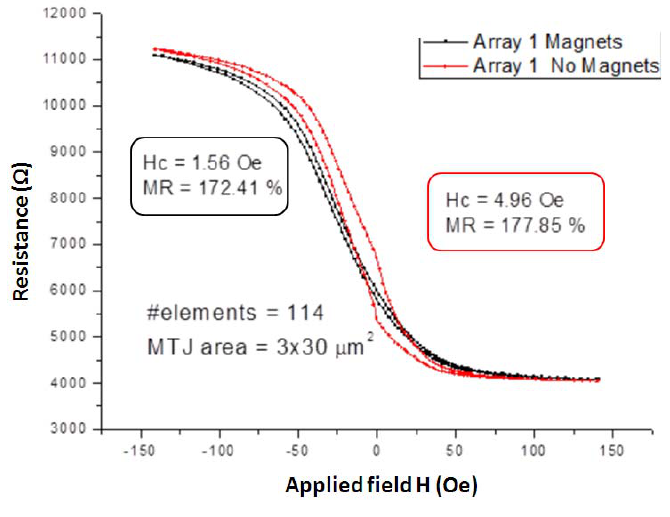
Figure 5. R-H characteristic of the TMR sensor used in this work (177% MR), [36]. f